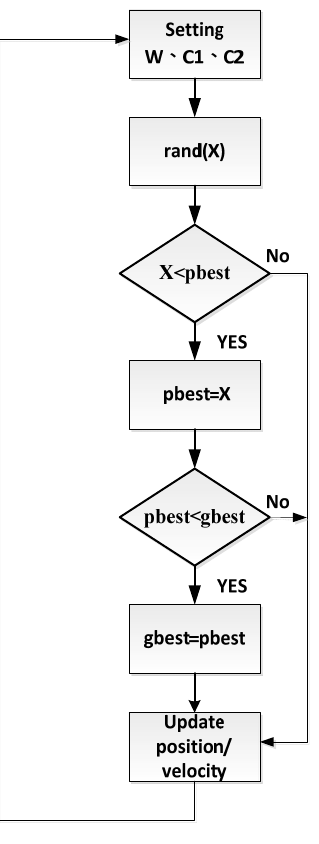
Figure 3. PSO flow chart.